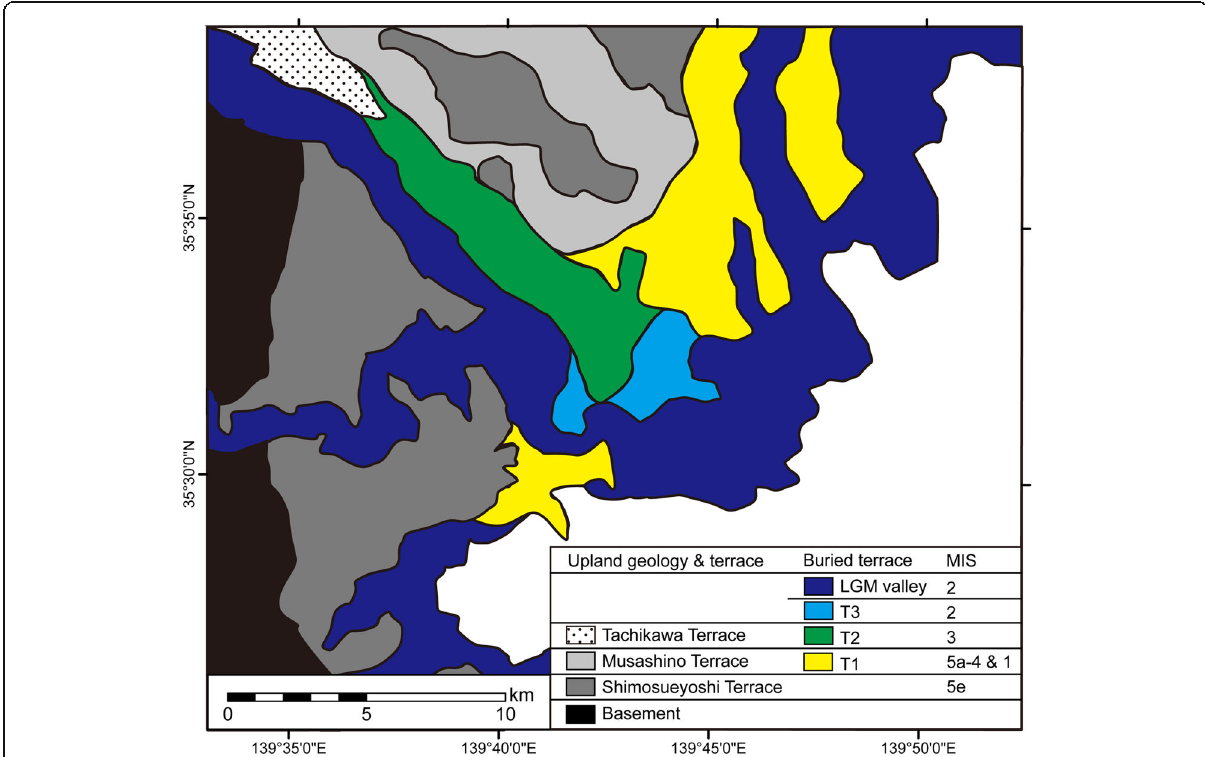
Fig. 8 Classification of upland and buried terraces and LGM incised valleys, all correlated with marine isotope stages. T1 buried terrace 1, T2 buried terrace 2, T3 buried terrace 3, LGM valley LGM incised valley. MIS marine isotope stage. The T1 partly contains abrasion platforms formed during the middle Holocene sea-level highstand; therefore, it is correlated to MIS 5a – 4 and MIS